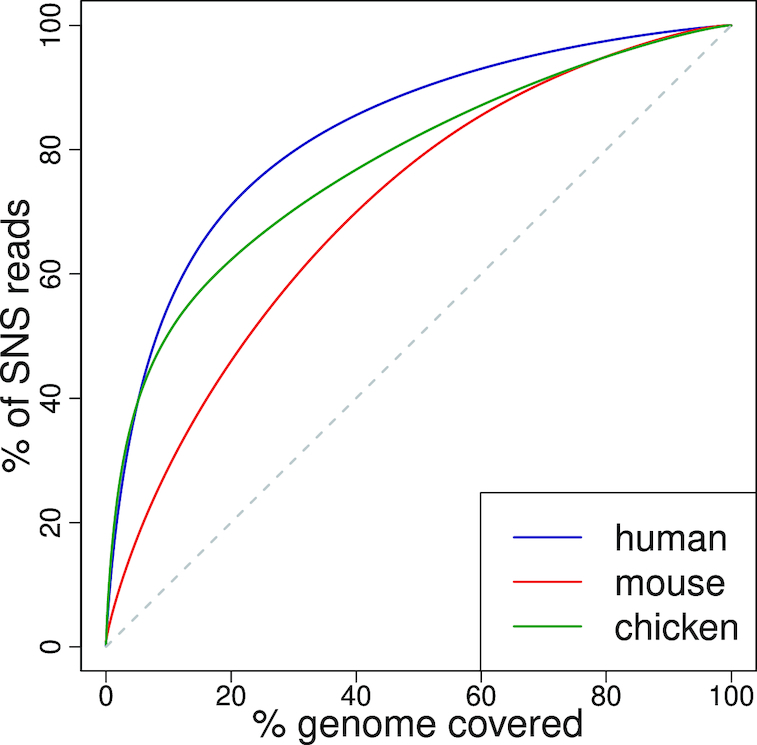
Replication initiation landscapes in vertebrates: Cumulative proportion of SNS reads mapped to the x richest 100 kb regions of the genomes. The black broken line corresponds to the expectation under a uniform distribution of reads.